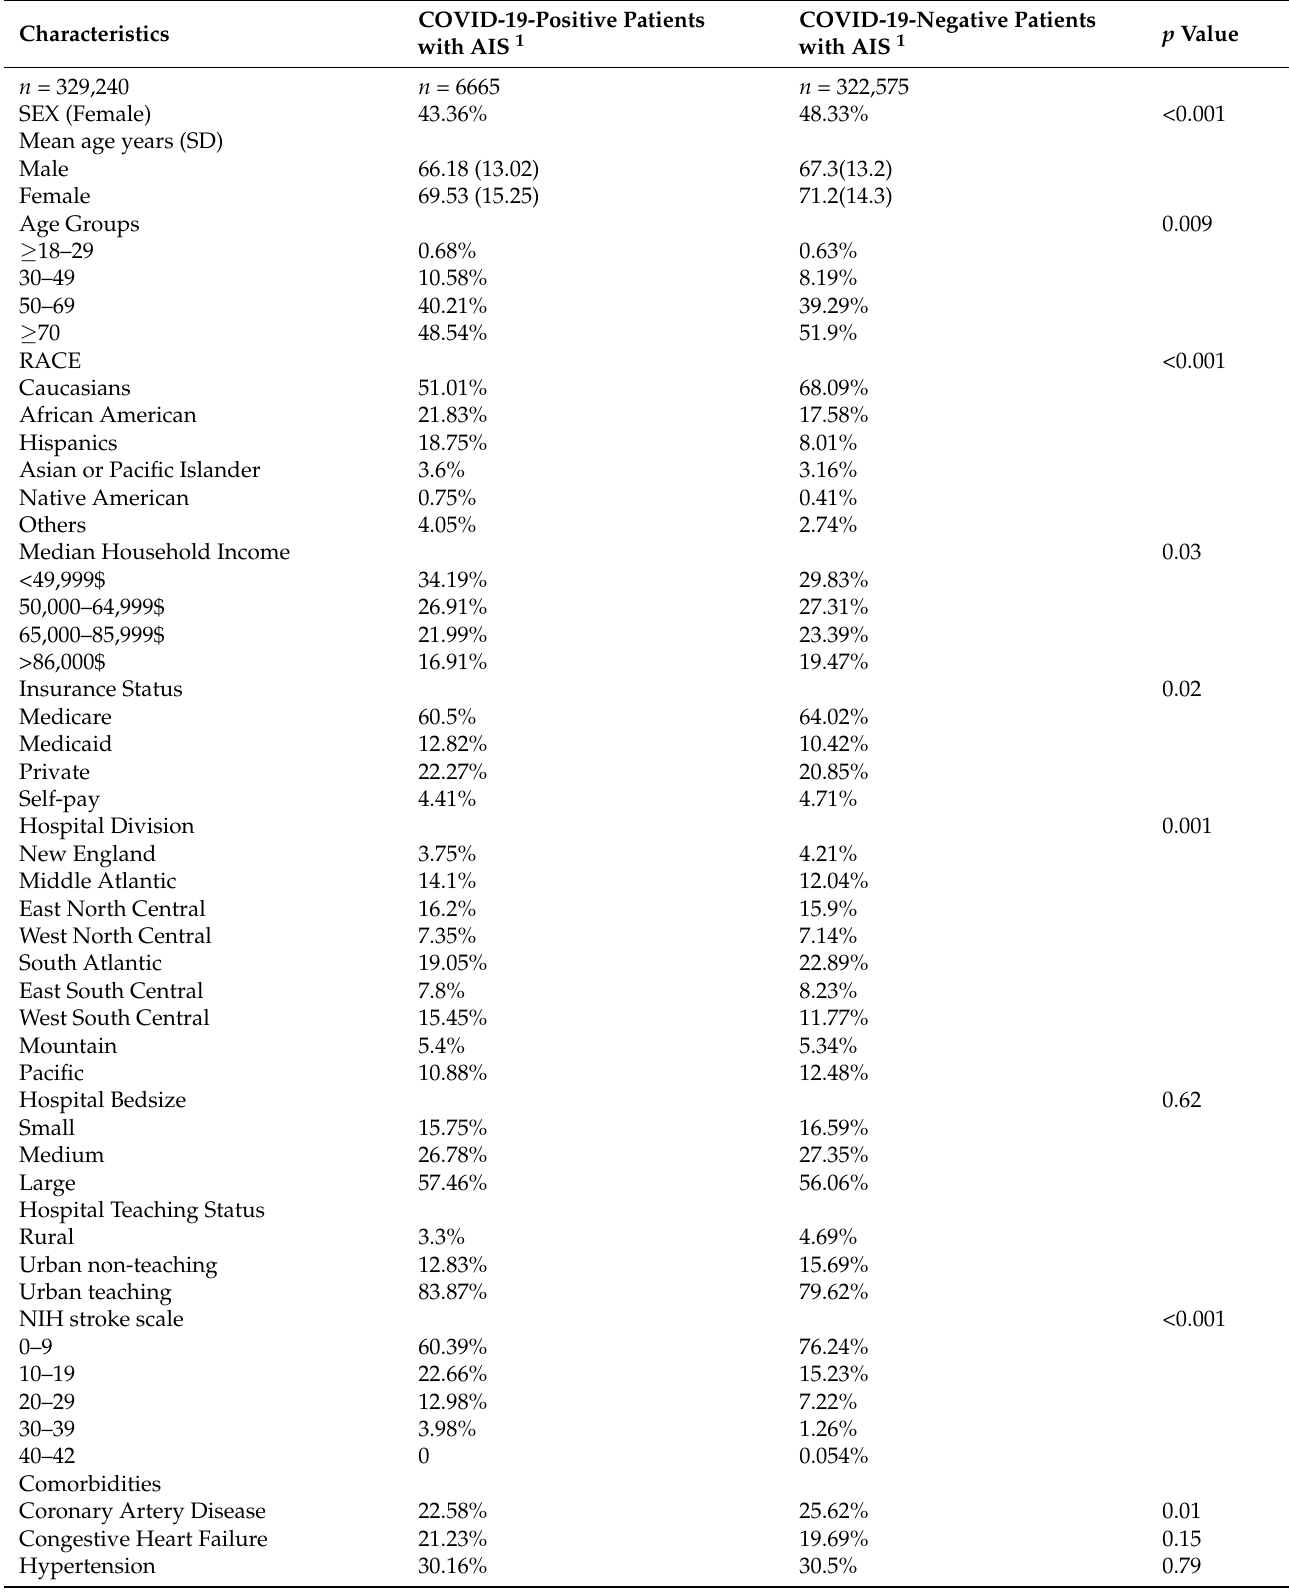
Table 1. Ischemic Stroke: patient-level characteristics for COVID-19-positive patients with acute ischemic stroke and COVID-19-negative patients with acute ischemic